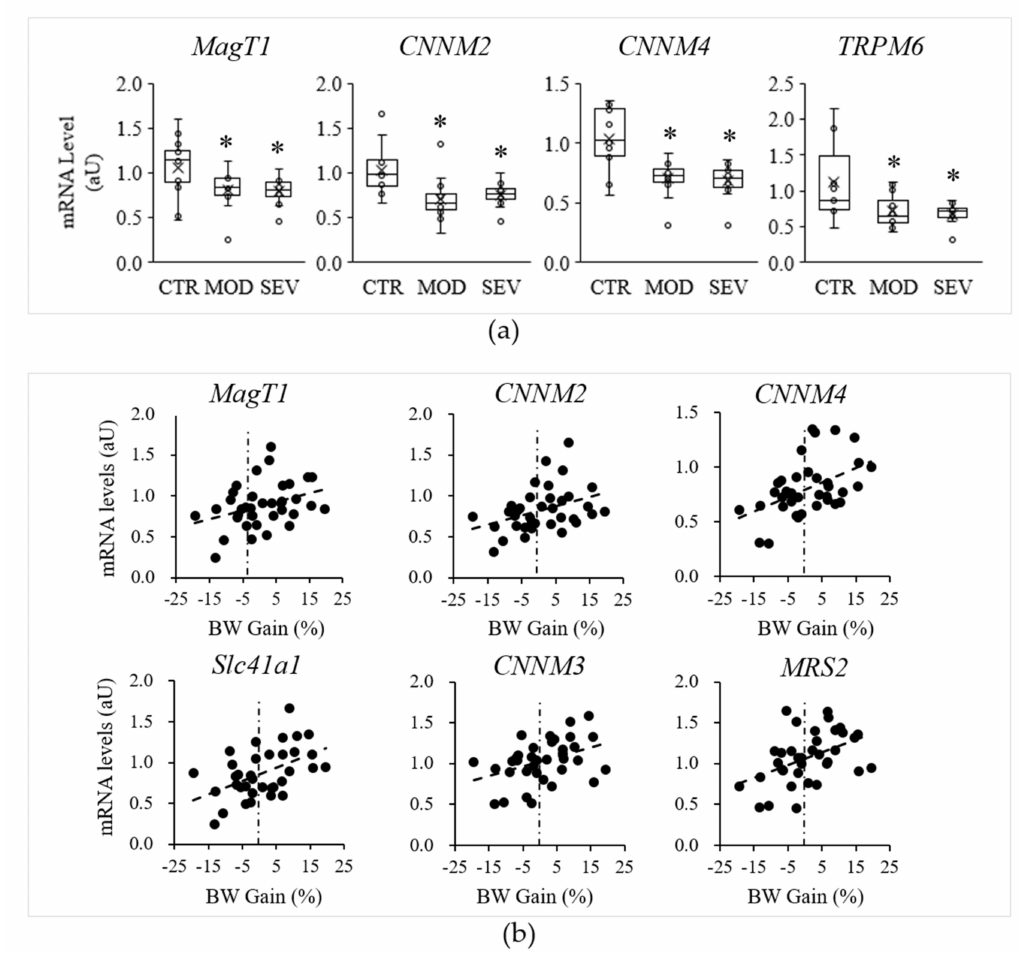
Figure 4. Mg 2+ -deficient diet and muscle Mg 2+ transport and homeostatic systems (MgTHs) mRNA levels. Mice were fed either a control (CTR), a mildly (MOD), or a severely (SEV) Mg 2+ -deficient diet: ( a ) gastrocnemius MgTHs mRNA levels; data (N = 12) are presented as box-and-whisker plots; * indicates significant difference ( P < 0.05) from the CTR group; ( b ) examples of linear Pearson’s regressions between muscle MgTHs mRNA levels and body weight (BW)